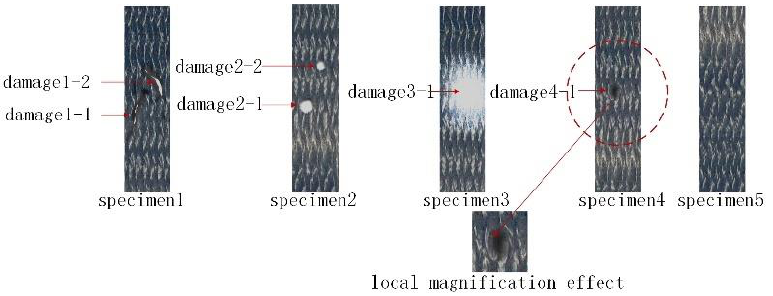
Figure 4. 3D braided composite specimens with different damages and no damages embedded in CNT yarn sensor.